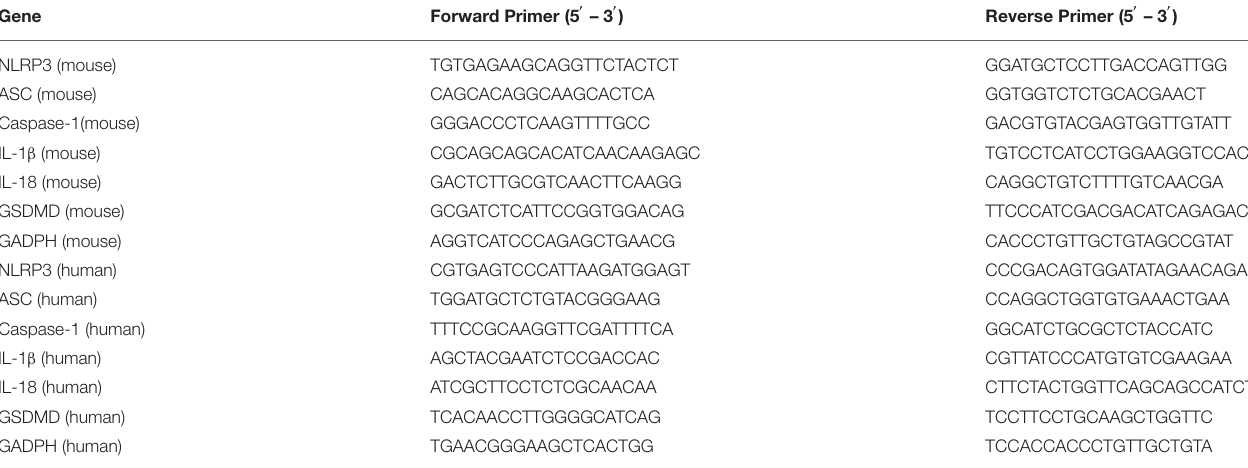
TABLE 1 | Primer sequences used for RT-qPCR. Gene Forward Primer (5 ′ – 3 ′